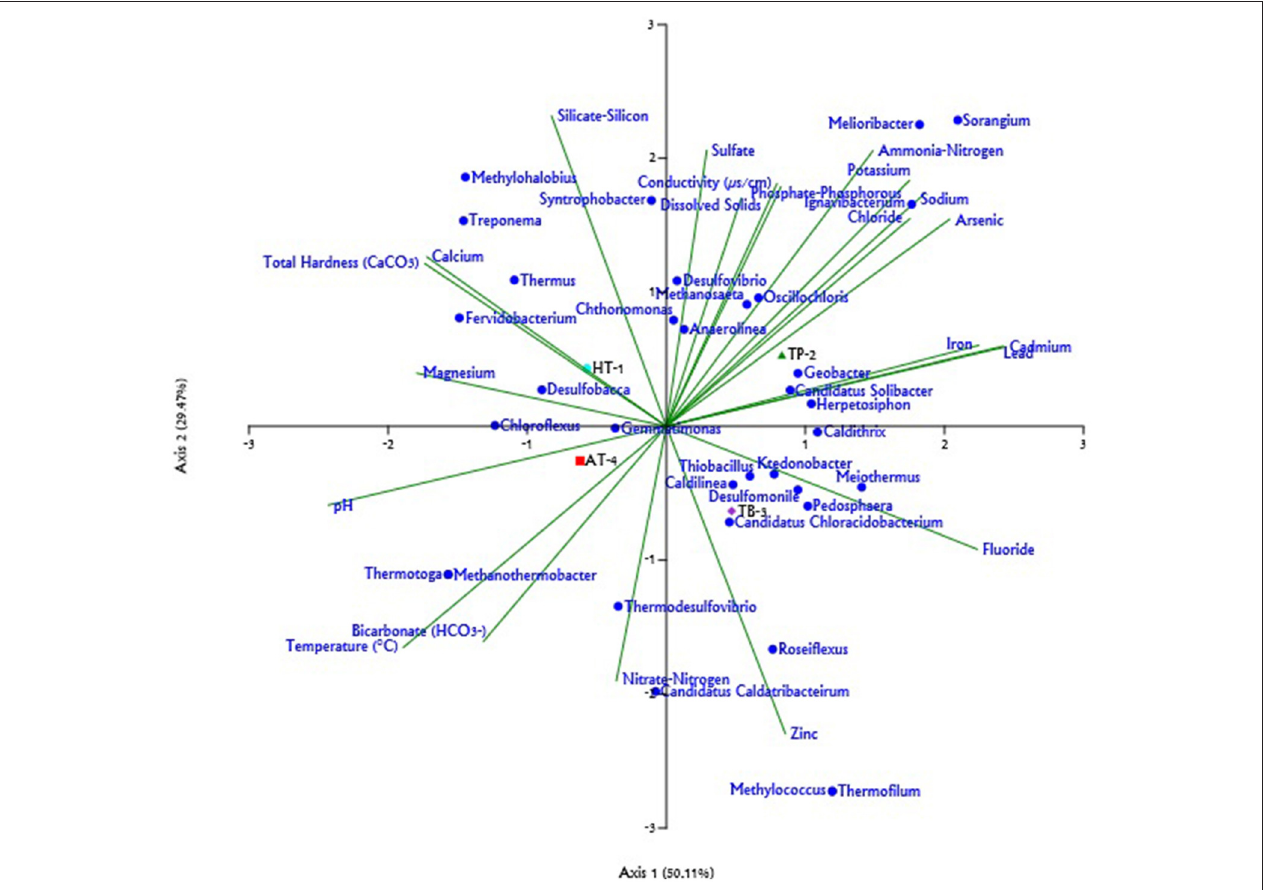
FIGURE 4 | Triplot generated for the Canonical Correspondence Analysis (CCA) of relative abundance of different genera (only those with > 1% represented in at least one sample) and 22 physicochemical parameters across hot springs. The physicochemical parameters are represented by green lines; the genera are shown as blue circles; and the hot springs: Athamallik (HT-1), Taptapani (TP-2), Tarabalo (TB-3), and Atri (AT-4) are shown as colored symbols. The length of line indicates which physicochemical parameters most strongly determined the genera